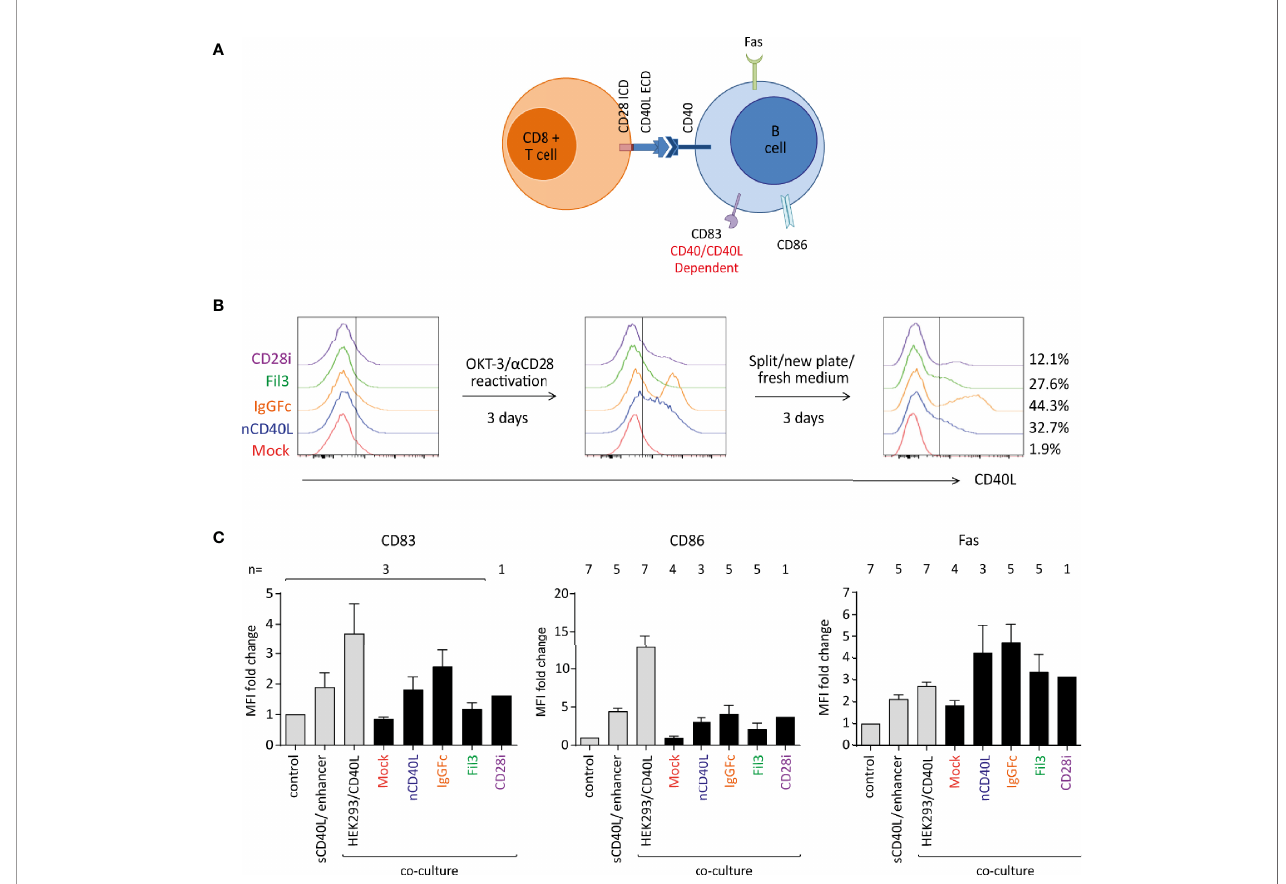
FIGURE 7 | Biologic activity of the CD40L ECD within the CSPs using a B cell stimulation assay. Primary human T cells transduced with the CSPs were re-activated, collected after 6 days when endogenous CD40L expression on Mock-T cells was absent, and co-cultured with freshly isolated B cells at a 1:1 ratio. Co-cultures were harvested and analyzed by fl ow cytometry for B cell-speci fi c surface activation markers CD83, CD86 and Fas. Three controls were included: i) a negative control consisting of B cells without T cells (unstimulated control), ii) a positive control using B cells stimulated with a soluble enhanced trimeric CD40L, and iii) B cells co- cultured with CD40L-expressing HEK293 cells. (A) Schematic diagram of the stimulation assay. (B) Histograms depicting the CD40L:CD28 CSP expression on the transduced T cells after thawing and anti-CD3/CD28 re-activation and culture for 6 days. (C) Graphs depicting the fold change of median fl uorescence intensity (MFI) relative to control of CD83, CD86 and Fas on the surface of B cells after overnight co-culture with T cells transduced with CD40L:IgGFc:CD28 depicted in orange, CD40L:Fil3:CD28 CSP depicted in green and T cells with CD40L:CD28i CSP depicted in purple. Mock-transduced T cells (red) and T cells transduced to express the native CD40L (blue) were used as references. Controls are the fi rst three bars distinguished by light grey color. Bars are the mean values of indicated number of independent experiments. Error bars are the standard deviation of the corresponding number of experiments